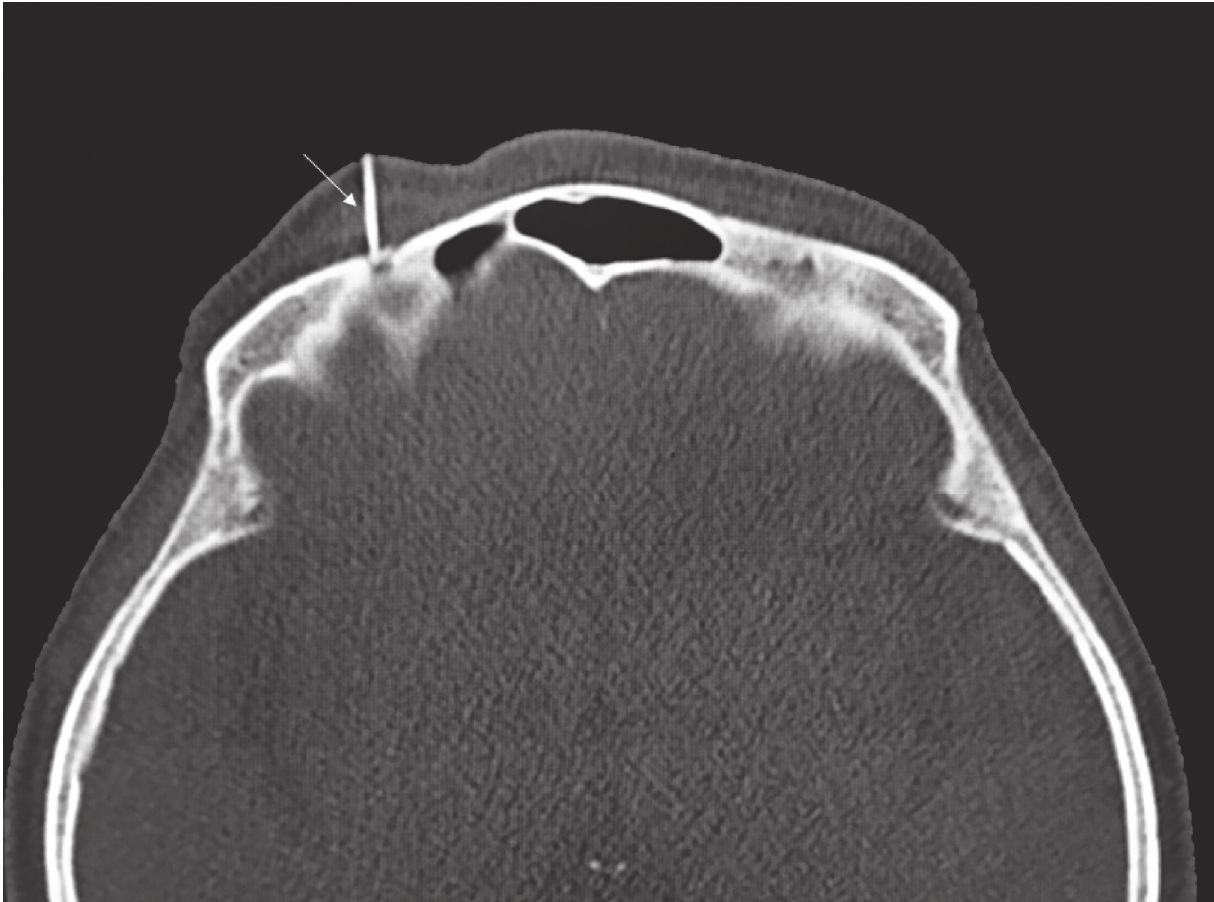
Figure 1: Computed tomography scan showing that the tip of the radiofrequency needle was located in the supraorbital foramen. The white line entering the skull is the radiofrequency needle (with white arrow